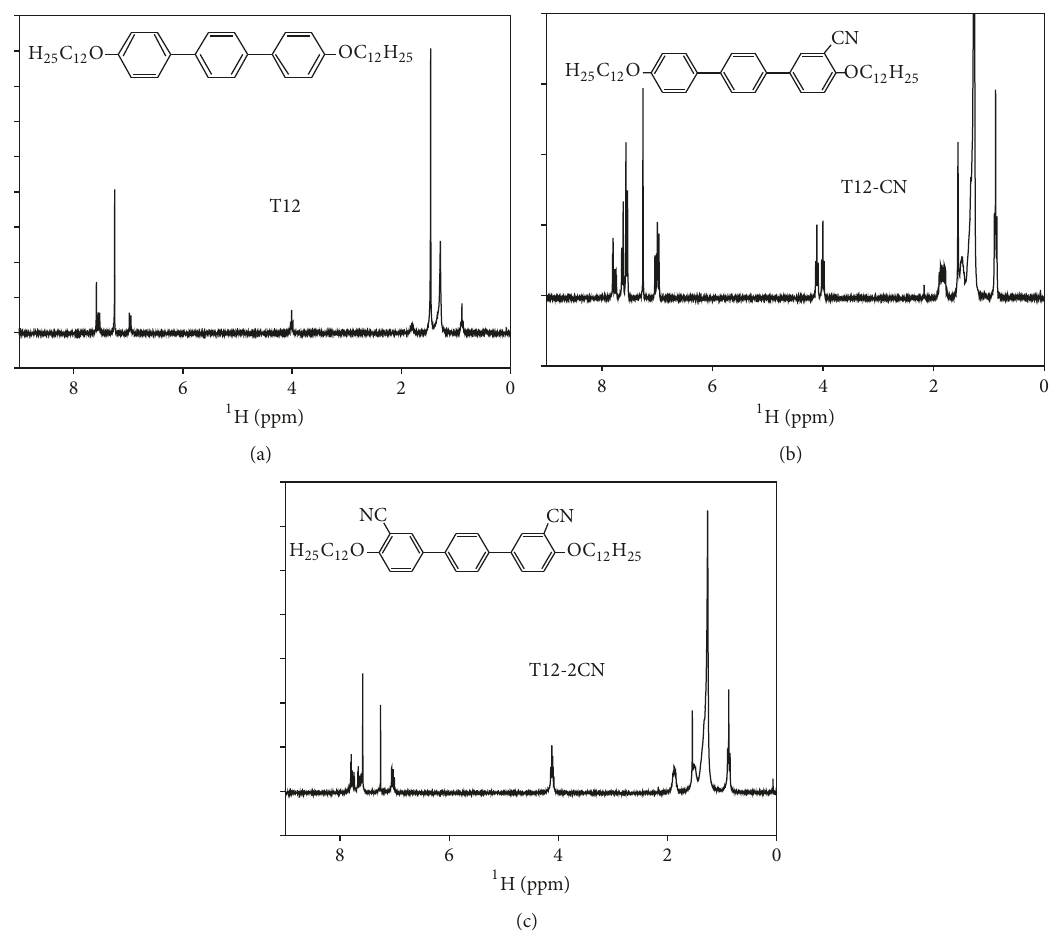
Figure 1: 1 H NMR spectra of